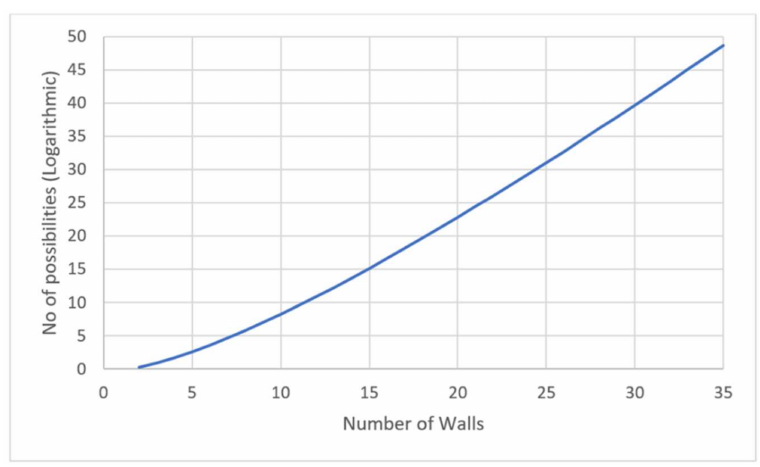
Figure 6. Number of path possibilities with respect to the number of walls.